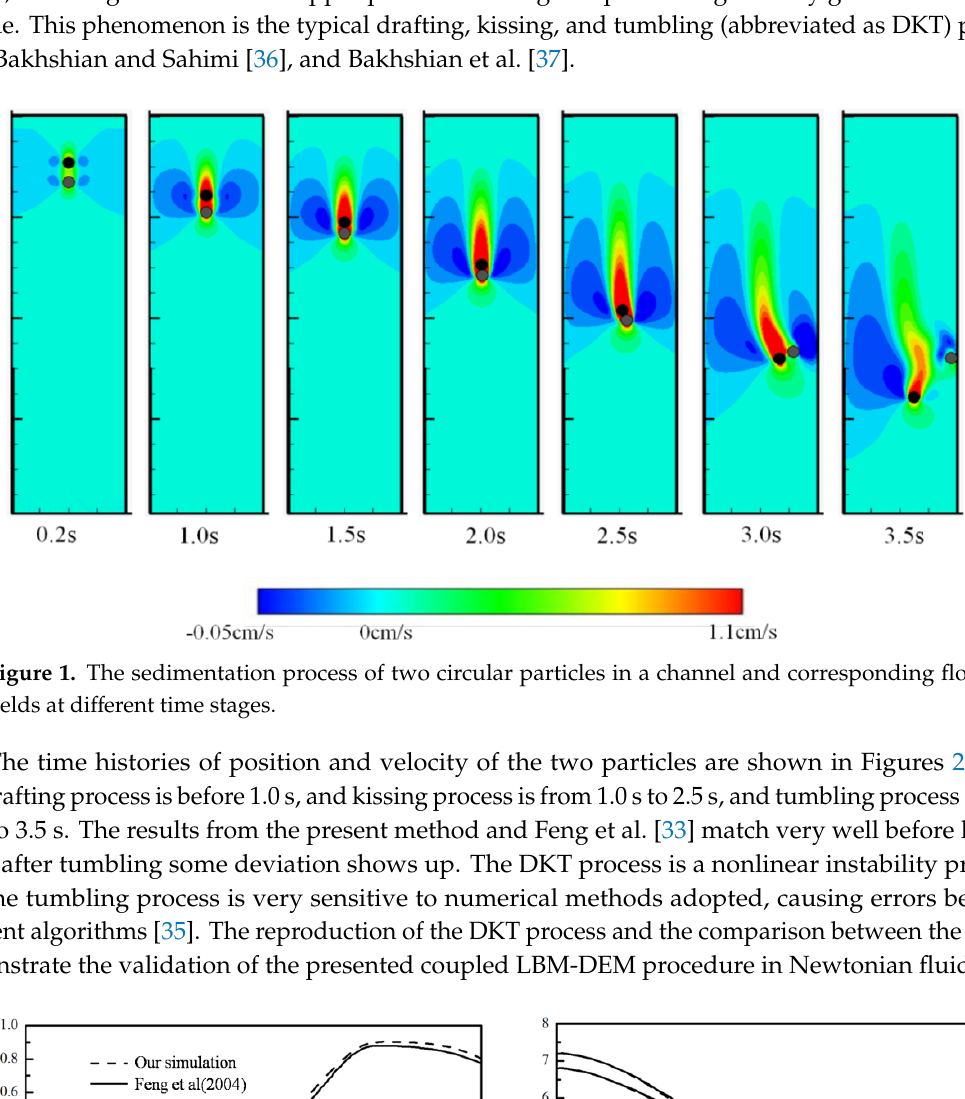
Figure 2. Coordinates of the two particles (left: x direction; right: y direction).